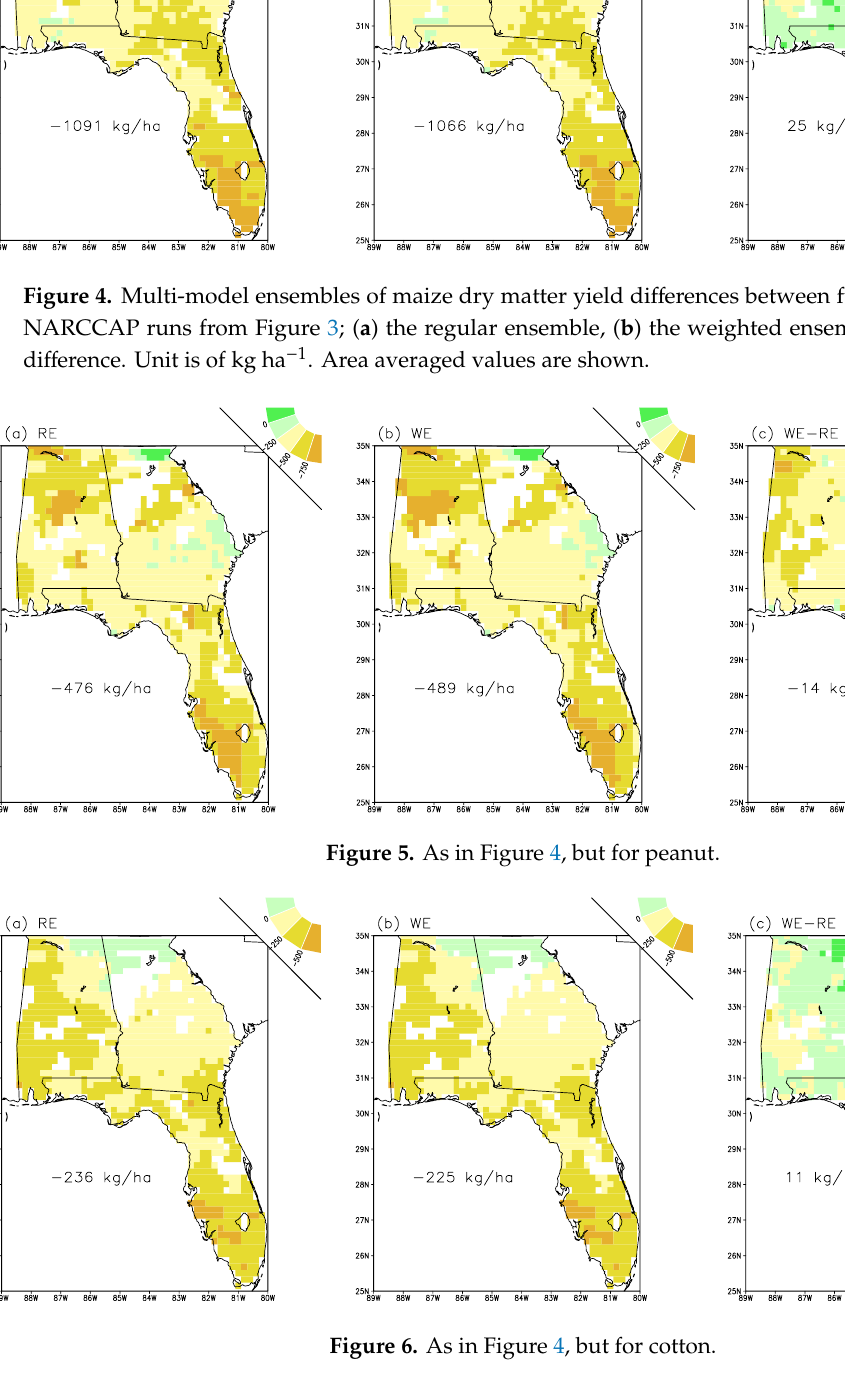
Figure 6. As in Figure 4, but for cotton.